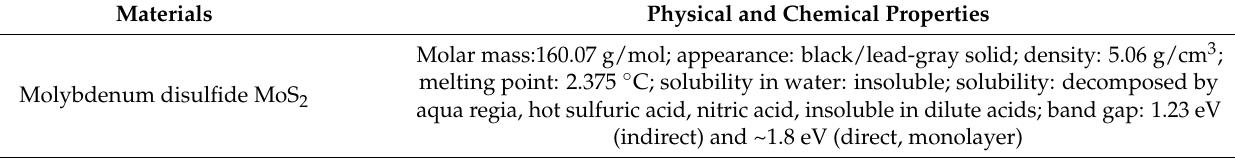
Molybdenum disulfide MoS